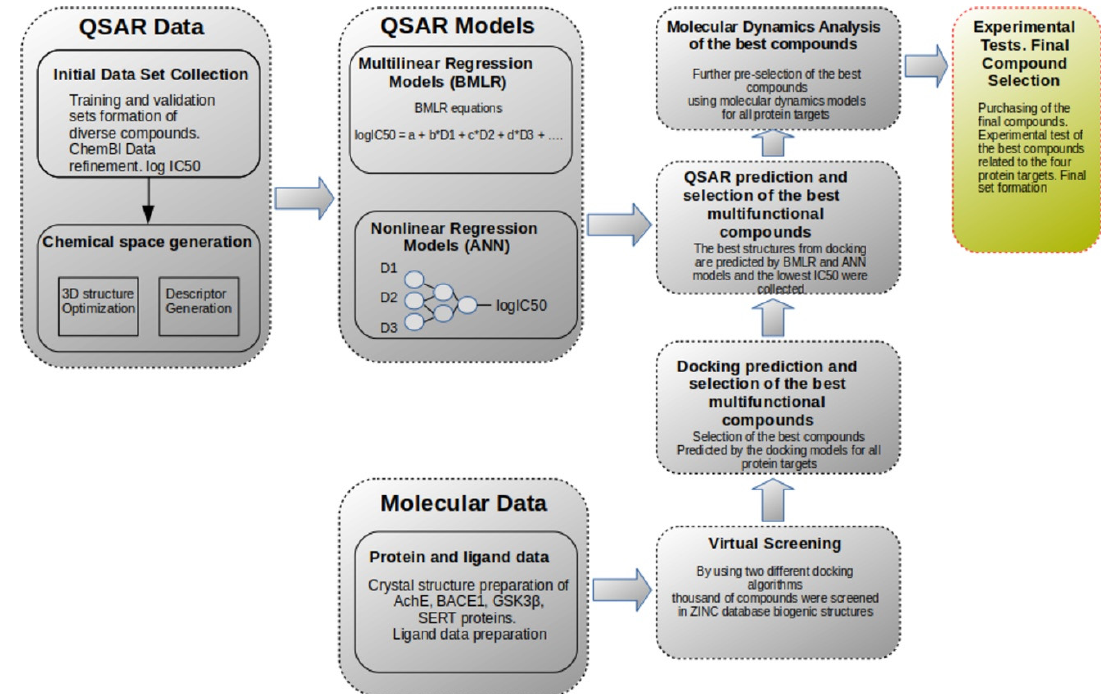
Figure 1. General workflow of the computational studies.